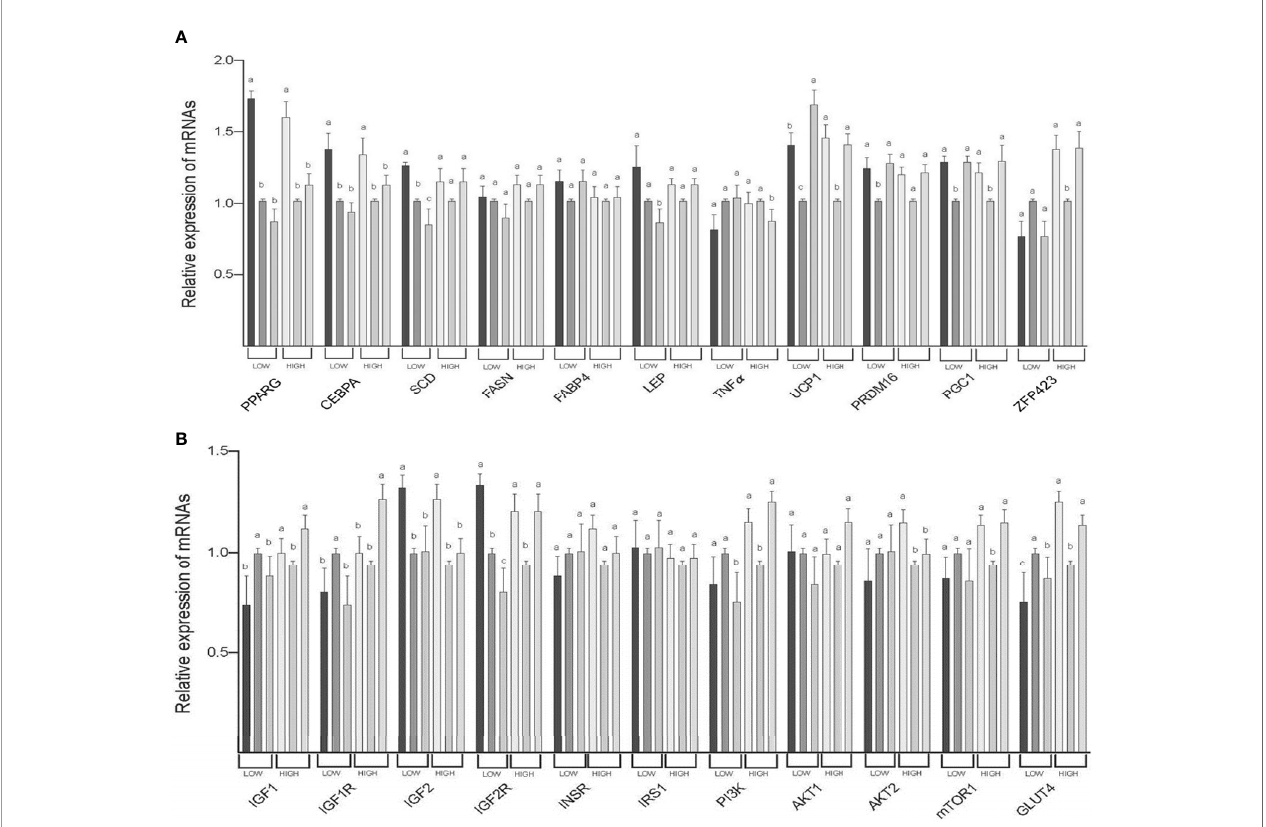
FIGURE 3 | Comparison of mRNA abundance among subcutaneous (SAT), thoracic cavity visceral (TVAT), and perirenal adipose tissues (PAT) in the LOW and the HIGH fetuses in Wagyu cattle. (A) Adipogenesis including brown adipose tissues (LOW/HIGH), (A) growth factors, and glucose metabolism (LOW/HIGH). Fetuses: 260 ± 8.3 days of fetal age. LOW: n=6. HIGH: n=6. a,b,c Signi fi cant difference ( p < 0.05) among SAT, TVAT, and PAT in the LOW and the HIGH